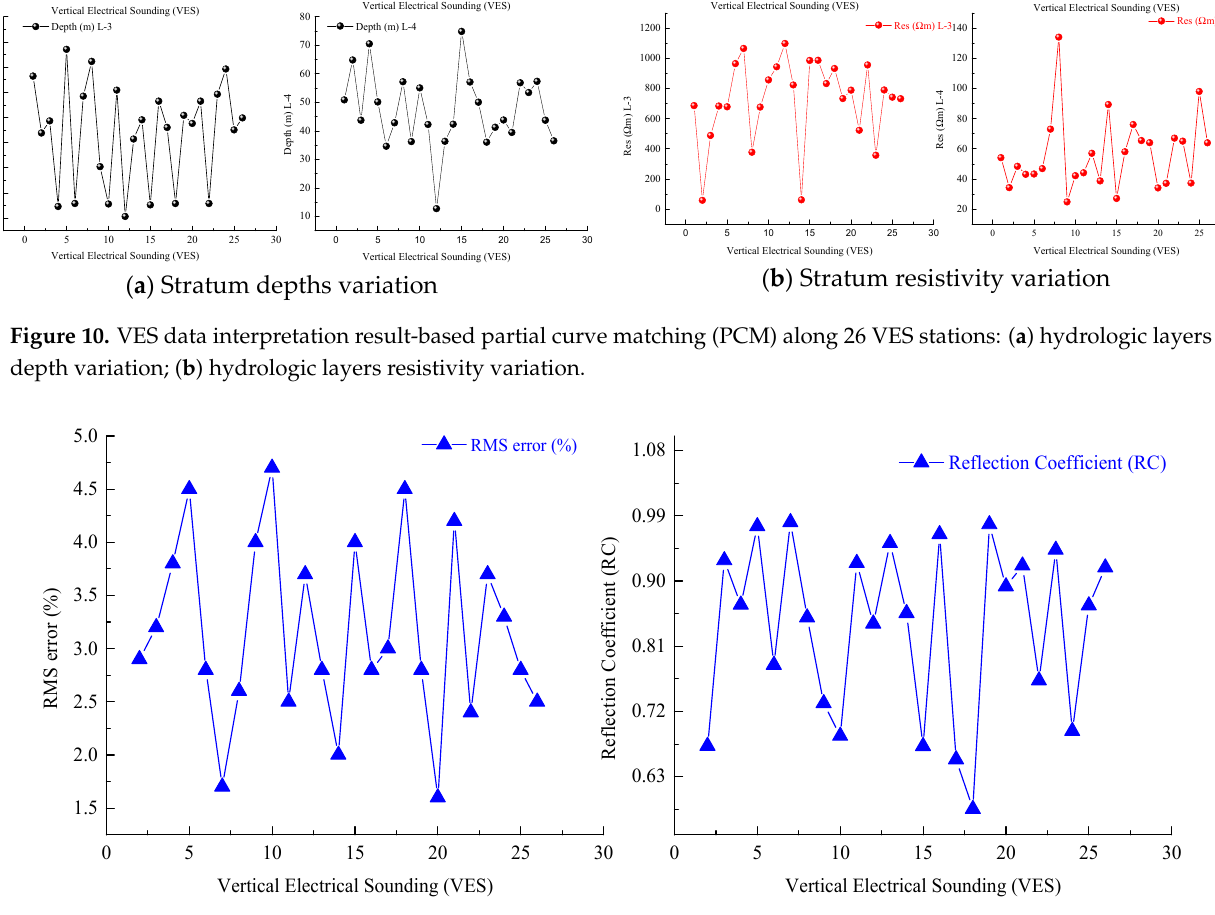
Figure 11. Root mean square (RMS) error of 26 VES stations ( left ) and the reflection coefficient variation of VES stations ( right ) in the study area. Table 6. Average inferred hydro-stratigraphy corresponding to resistivity in the study area. The detailed VES interpretation results are shown in Appendix